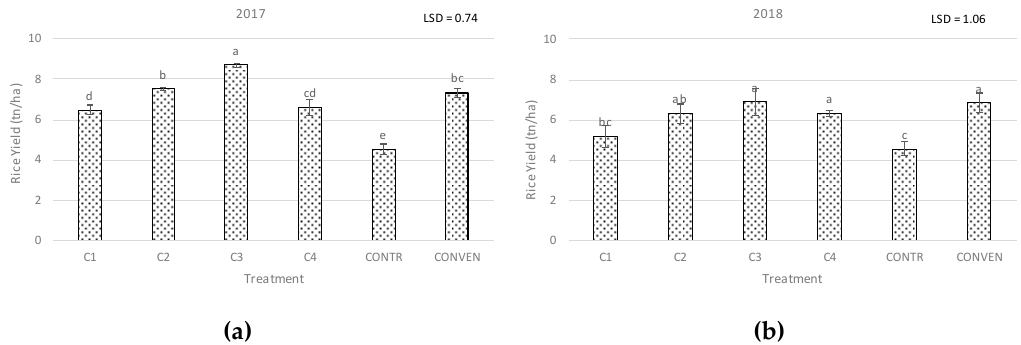
Figure 8. Yield of rice plants (means ± se) grown in differently fertilized soil of the experiment during 2017 ( a ) and 2018 ( b ). Treatments contain compost application of (i) 80 kg ha − 1 N in split application (C1), (ii) 160 kg ha − 1 N in split application (C2), (iii) 320 kg ha − 1 N in split application (C3), (iv) 160 kg ha − 1 N in single application (C4), (v) an untreated control (CONTR), and (vi) 160 kg ha − 1 nitrogen chemical fertilizer (CONVEN). Means were compared by the Bonferroni adjusted LSD value at p < 0.05. Different letters characterize significant differences between treatments. Full description of the treatments examined is given in Table 3.